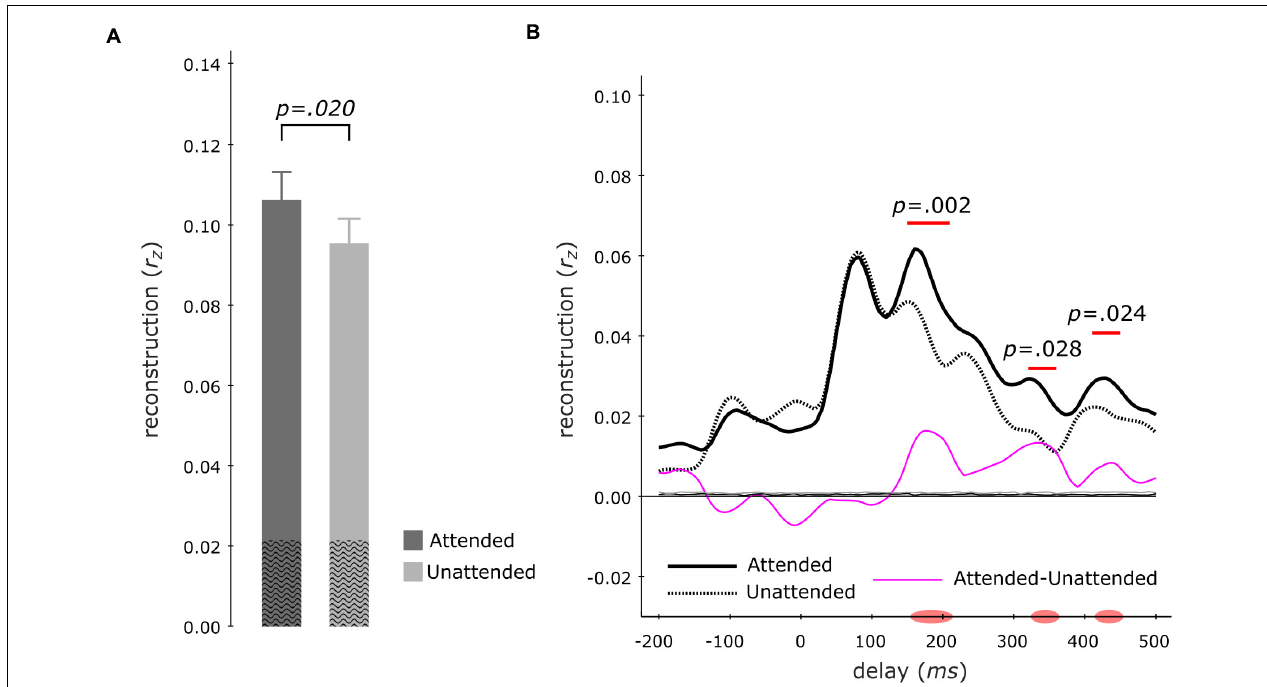
FIGURE 4 | Envelope Tracking during the Segregation Tasks. Multi-delay model tracking performance (A) for attended (dark gray) and unattended (light gray) instruments, showing a significant difference between the two listening conditions. The average empirical chance-level is displayed as superimposed black waves. Single-delay tracking profiles (B) showing a significant delay-resolved difference between attended (thick black solid line) or unattended (thick black dashed line) instruments during 150–220 ms, 320–360 ms, and 410–450 ms. The thin purple line shows the difference between attended and unattended tracking; the thin solid black (attended) and thin dashed black (unattended) lines present the average empirical chance-level.